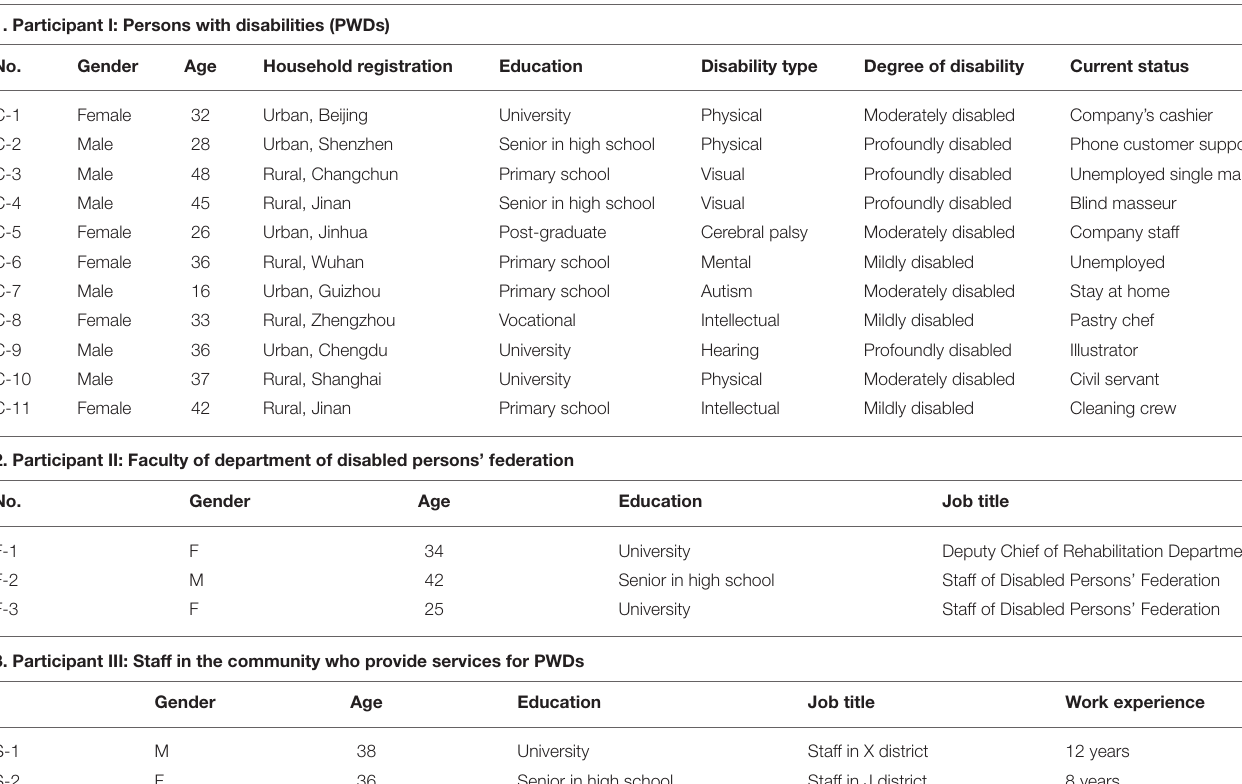
TABLE 1 | Description of research